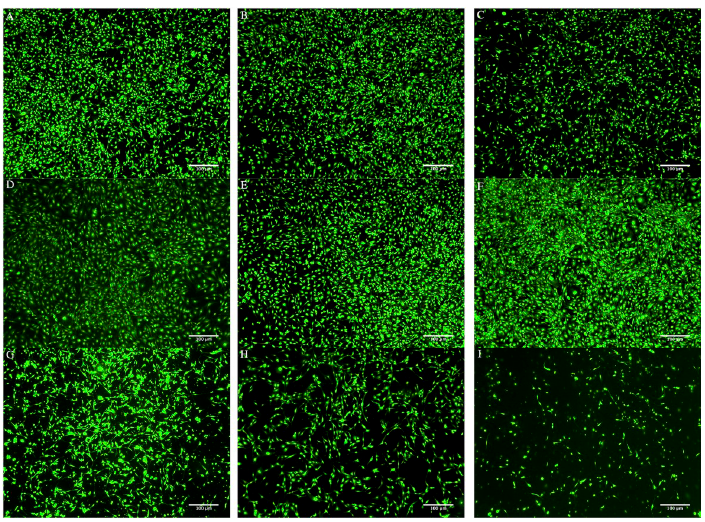
Fig 4. After day 7, the cell viability of co-culturing with different inorganic nanoparticles: (A) control, (B) MNP 100 μ g/mL, (C) HAP 100 μ g/mL, (D) MNP 500 μ g/mL, (E) MNP 750 μ g/mL, (F) MNP 1000 μ g/mL, (G) HAP 500 μ g/ mL, (H) HAP 750 μ g/mL, and (I) HAP 1000 μ g/mL.